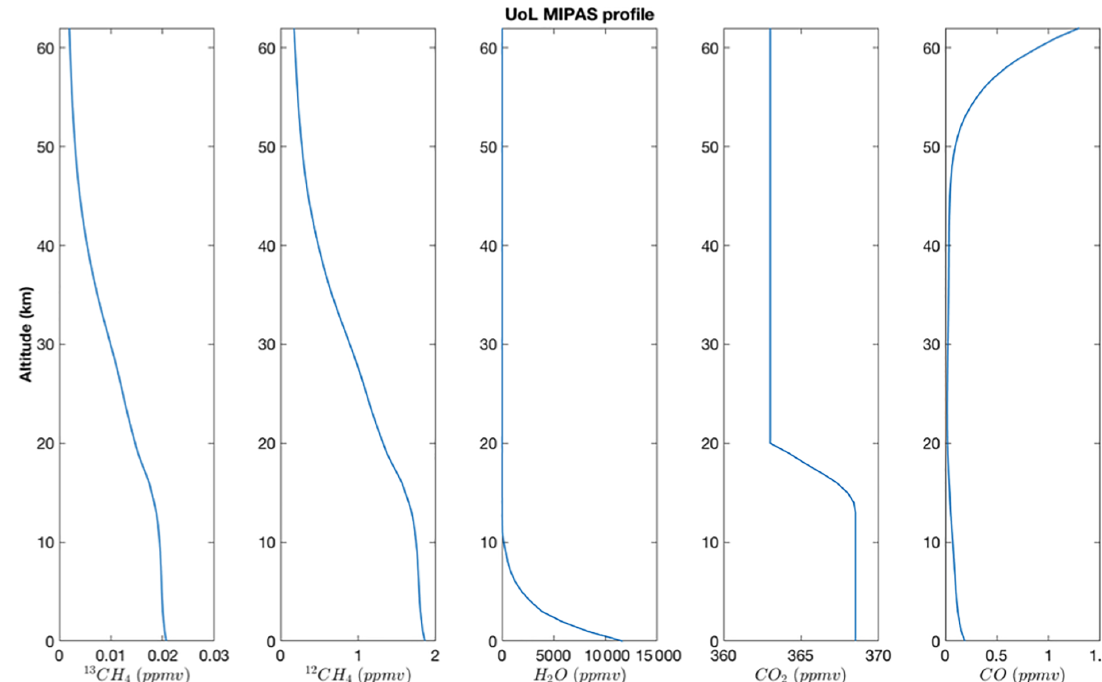
Figure 2. A priori gas concentration profiles of the main gases of interest. 13 CH 4 covariance matrix to values of (3 %)